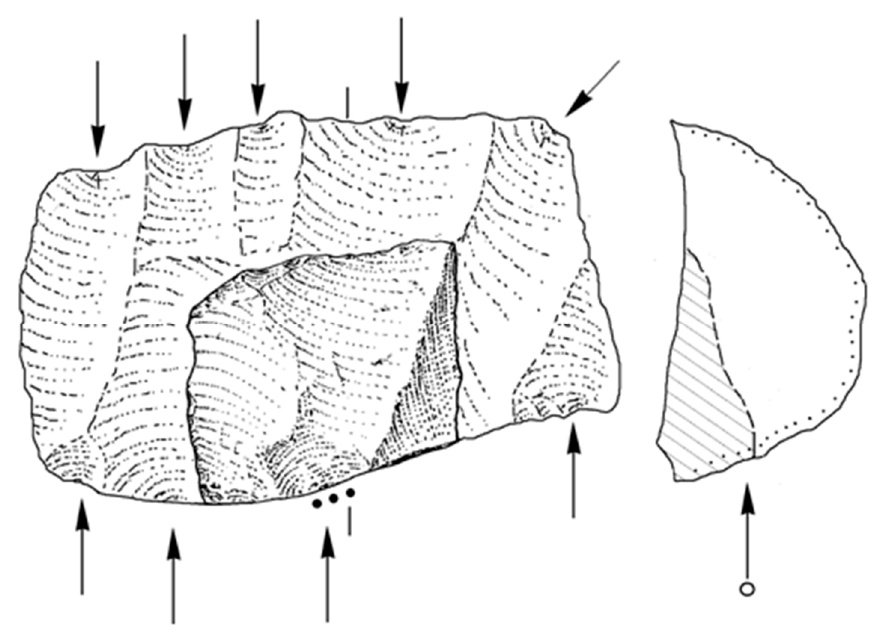
Figure 7. The flake from Figure 4 fitted on a virtual bidirectional core (typical for the Acheulian). (Drawing: L. Fiedler).